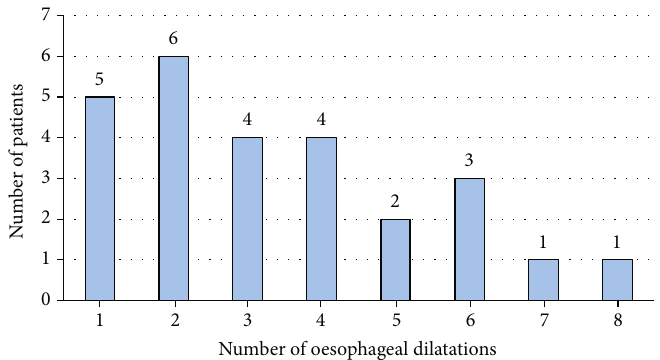
Figure 3: Numbers of endoscopic esophageal dilatations per patient performed for children with esophageal strictures. Table 2: Complications in 46 children with esophageal strictures with or without esophageal dilatations. Patients with esophageal strictures ( N = 46 Variables